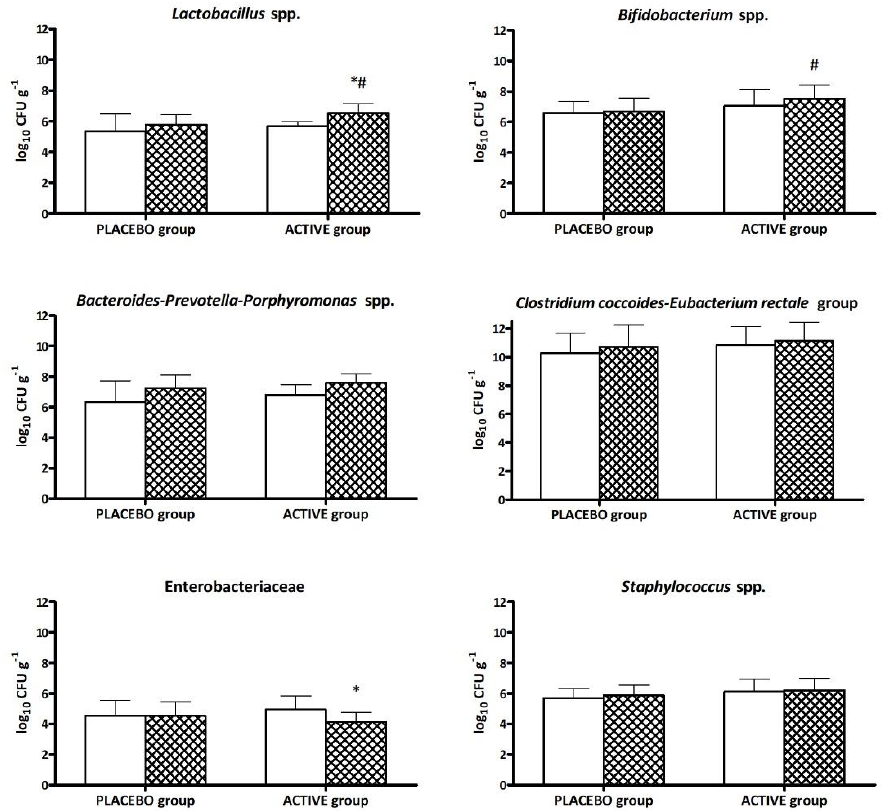
Figure 3. Fecal bacteria count (log 10 CFU g −1 ± SD) of target bacterial groups during the different time points ( T0 and T30 days) relative to the two groups of volunteers (PLACEBO and AC- TIVE). * Significantly different ( p < 0.05) from T0 and # from the placebo group at the same time point according to Tukey’s test following one-way ANOVA.